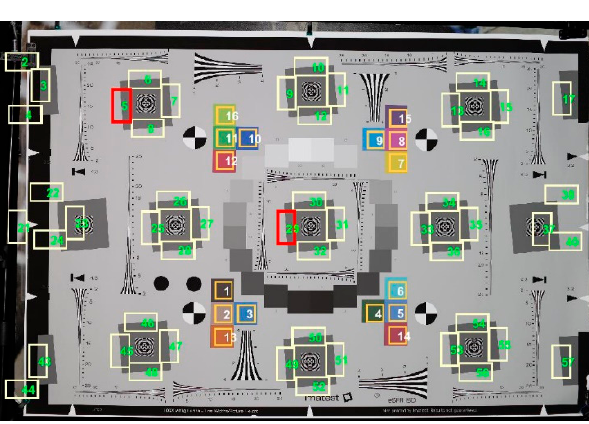
Figure 1. The used edge spatial frequency response (eSFR) ISO test chart target. Sixteen colours